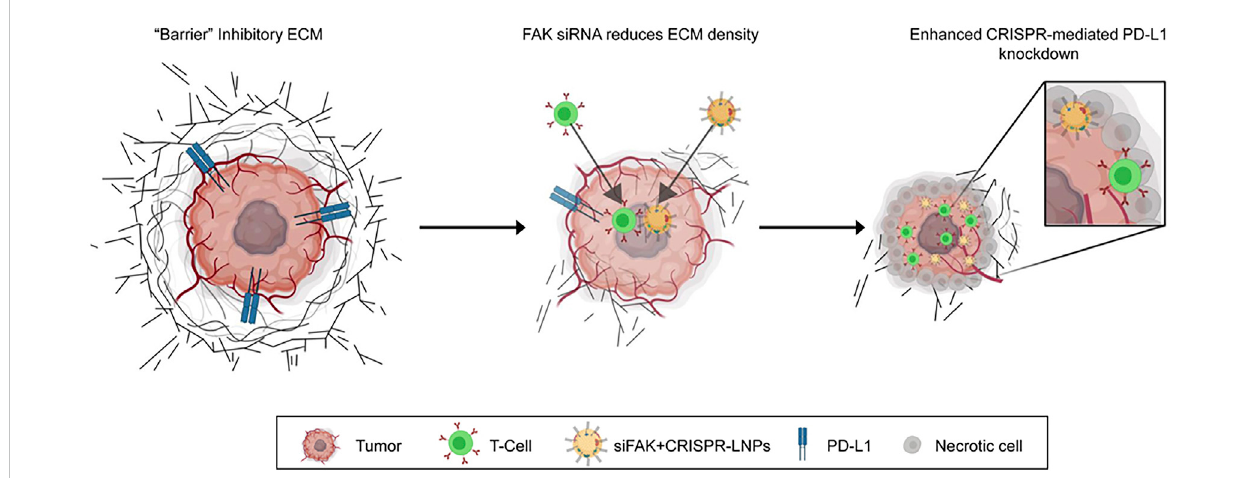
FIGURE 4 Schematicillustrationfortargetingthemechanicalpropertiesoftumorstoopenadouble-checkpointblockade(stiffECMplusimmunosuppression) to enable cancer therapy. Proposed model for how dendrimer LNPs encapsulating FAK siRNA, Cas9 mRNA, and targeted sgRNAs enhance penetration into tumors with increased gene editing of PD-L1 for improved cancer therapy (Zhang D. et al., 2022). Copyright © 2022, Springer